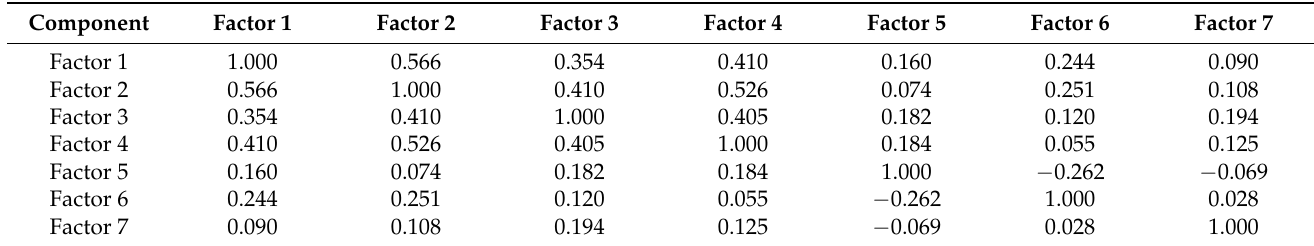
Table 4. Component correlation matrix for occupational health and safety standards practices in the mining